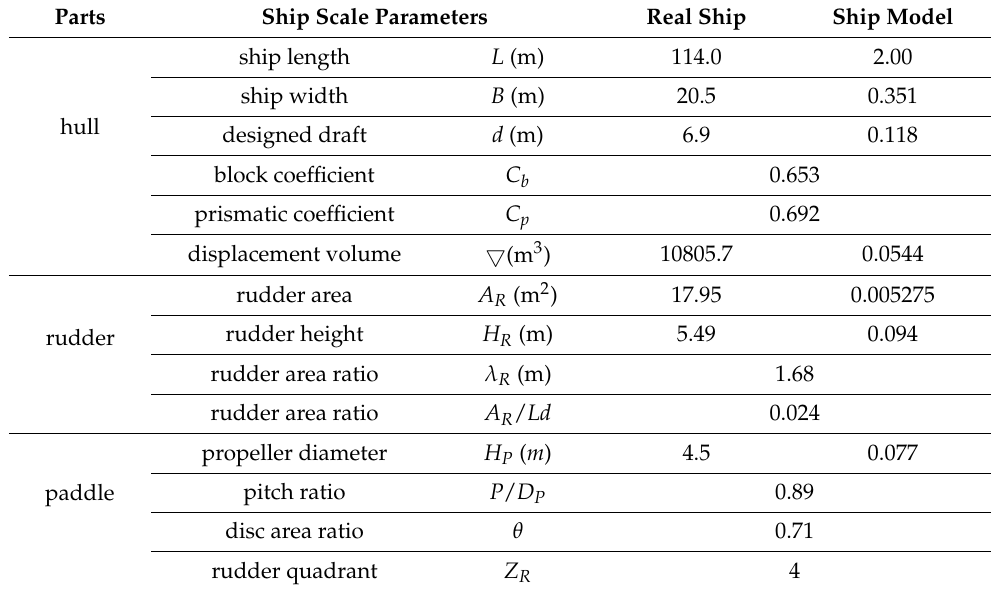
Table 2. Main scale table of test ship and ship model.